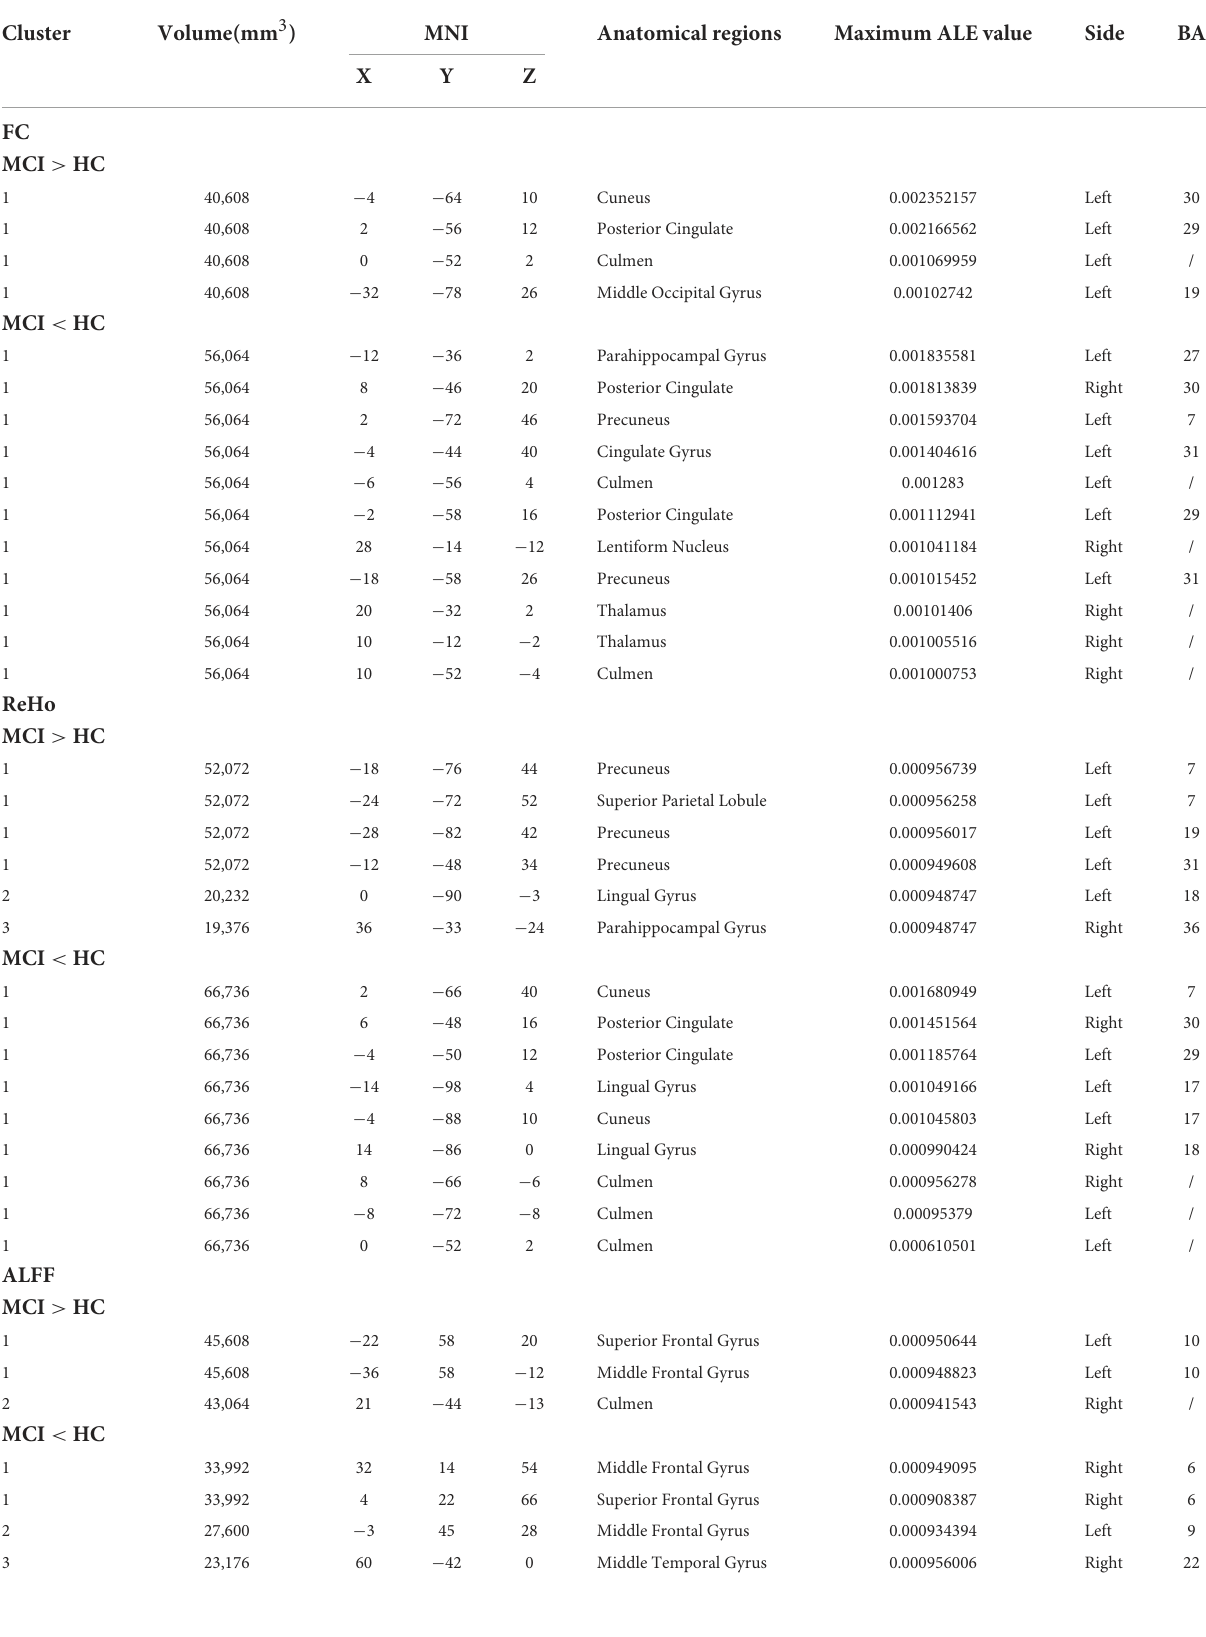
TABLE 2 All clusters from the ALE